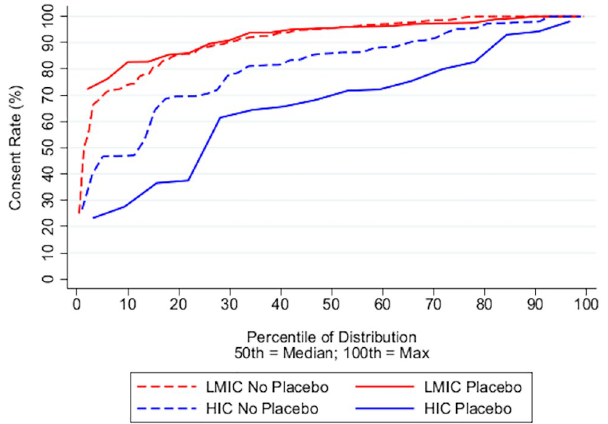
Fig 4. Distribution of LMIC vs HIC trial consent rates by control type (no placebo versus placebo). The cumulative density function depicts the percent of trials that have a consent rate equal to or less than each point on the y-axis. Across the entire distribution, HIC placebo trials had lower consent rates than HIC no placebo trials (p = 0.0111; Two- Sample Wilcoxon Rank Sum Test). There was little difference between the distribution of placebo and no placebo consent rates in LMIC trials (p = 0.8217; Two-Sample Wilcoxon Rank Sum